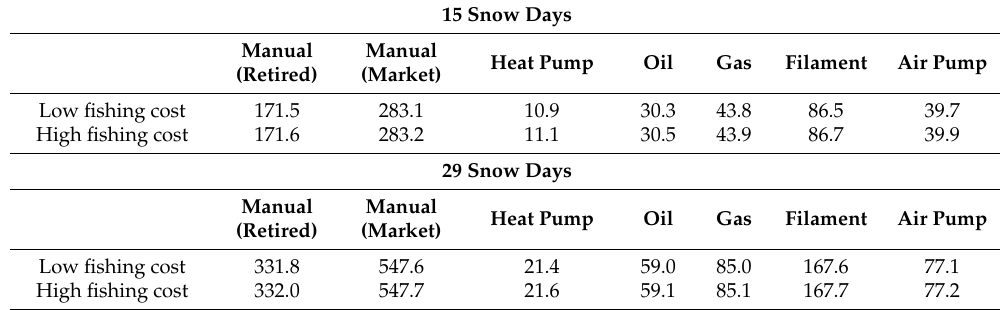
Table 4. The net benefit of increasing groundwater use for snow-melting in Obama by 50%, under different assumptions about alternative melting technologies, number of snow days, and fishing costs (million